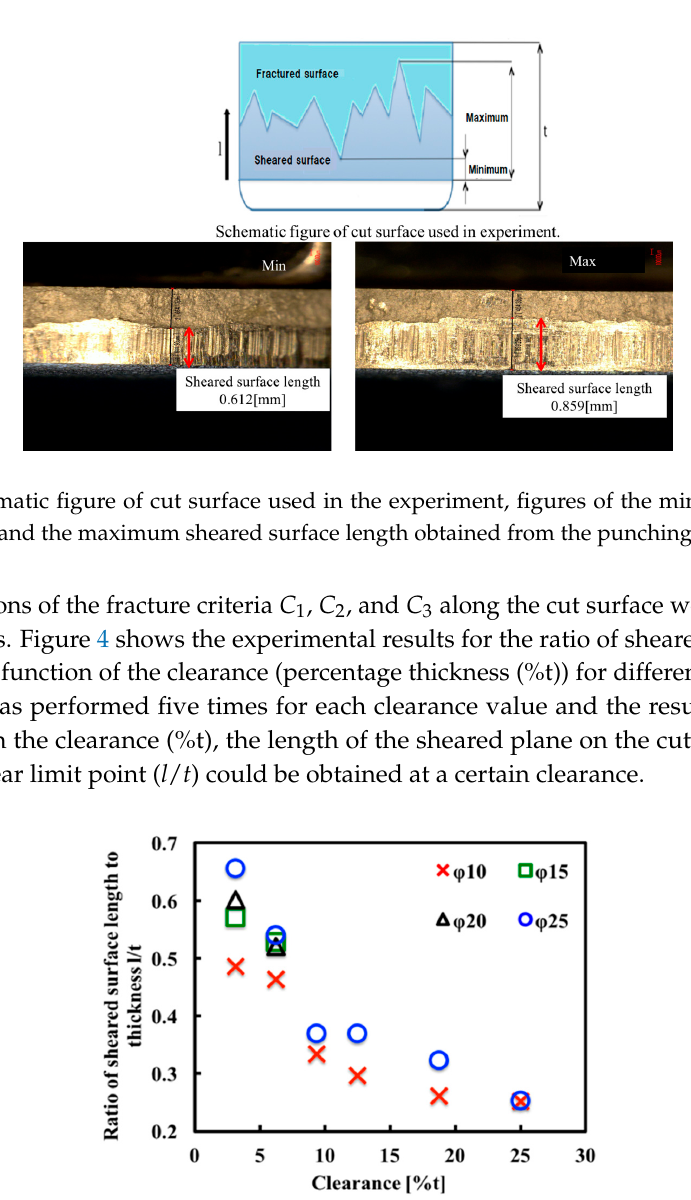
Figure 4. Relationships between the punch-die clearance and the ratio of sheared surface length to thickness obtained from the punching experiments with different punch diameters of 10, 15, 20, and 25 mm.